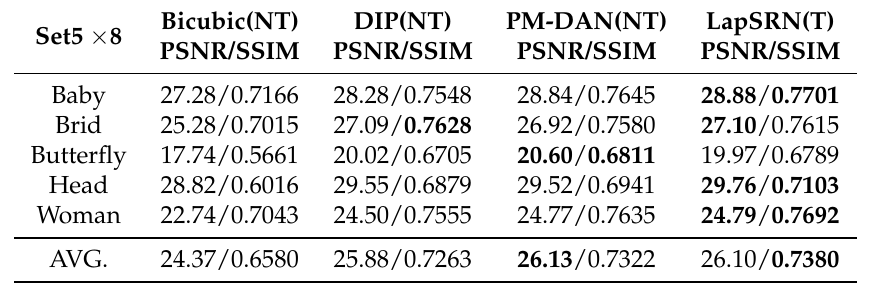
Table 4. 8 × SR comparison on Set5. The best PSNR and SSIM values are highlighted in